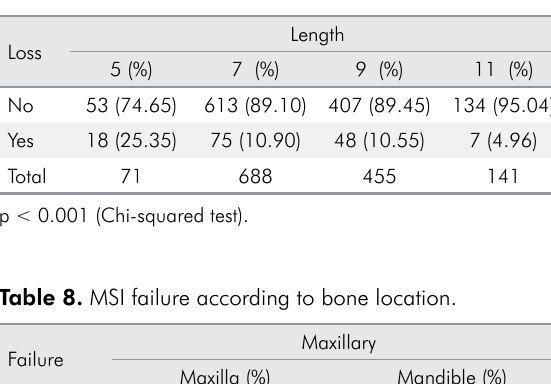
Table 7. MSI loss of stability according to length.